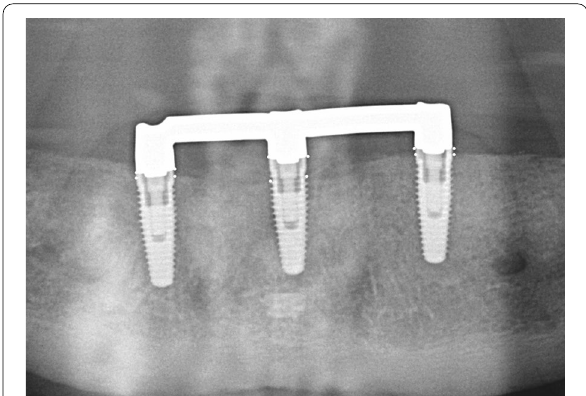
Fig. 4 Exemplary radiograph of the implant group BL‑TiUnite with surface on collar (Nobel Biocare AB, Zurich, Switzerland)